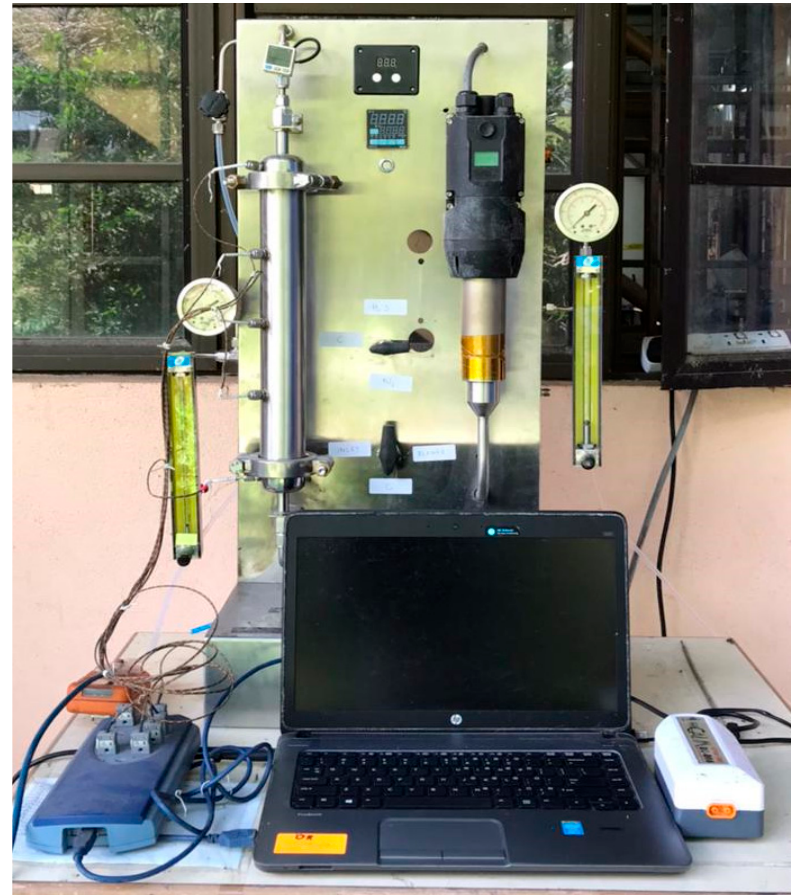
Figure 1. Experimental set-up for real test of adsorption–desorption of H 2 S gas.